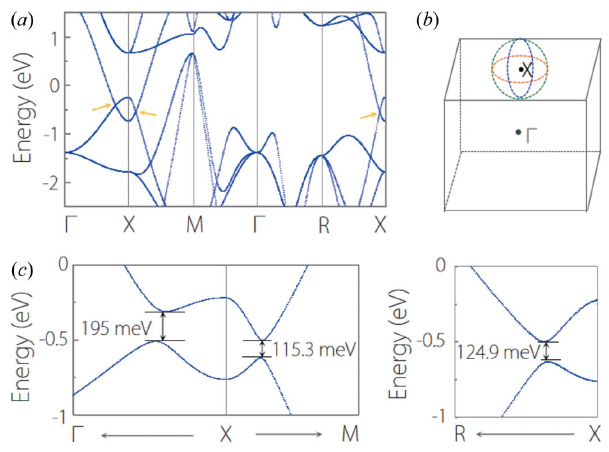
Figure 8 ( a ) Band structure of TiOs without SOC. ( b ) Schematic illustration of the three crossing nodal lines in TiO. ( c ) Enlarged band structure of TiOs with SOC at the (cid:2) – X – M and R – X